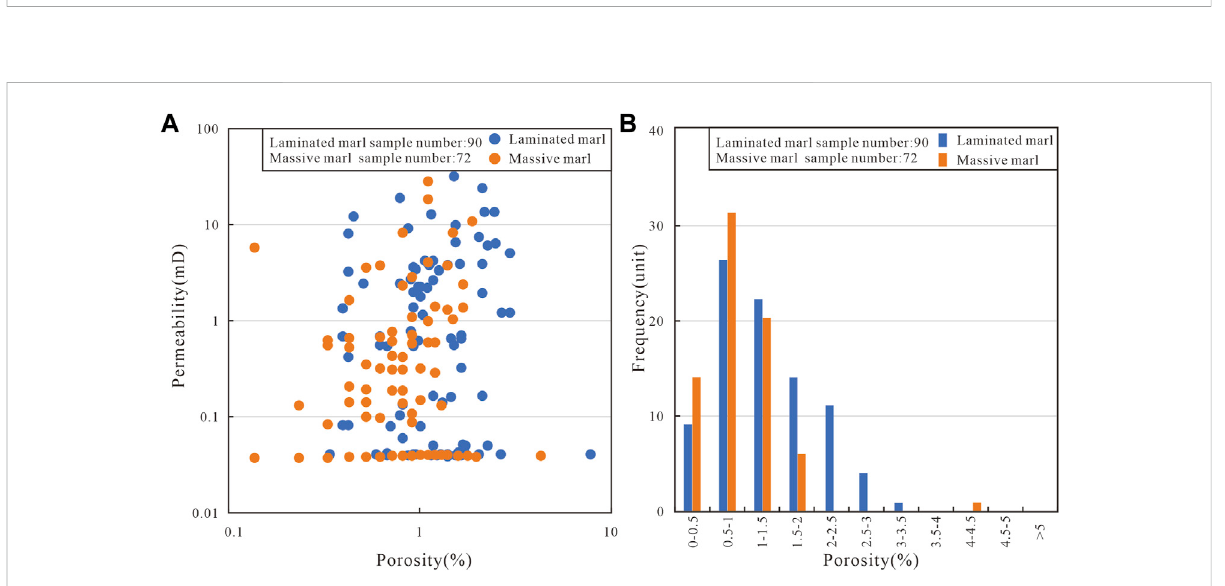
FIGURE 5 Marl reservoir porosity distribution and the porosity-permeability relationship of Shahejie Formation in the Shulu Sag: (A) , the relationship between porosity and permeability; (B) , reservoir porosity distributions showing the porosity variation mainly in the range of 0 – 2.5%.